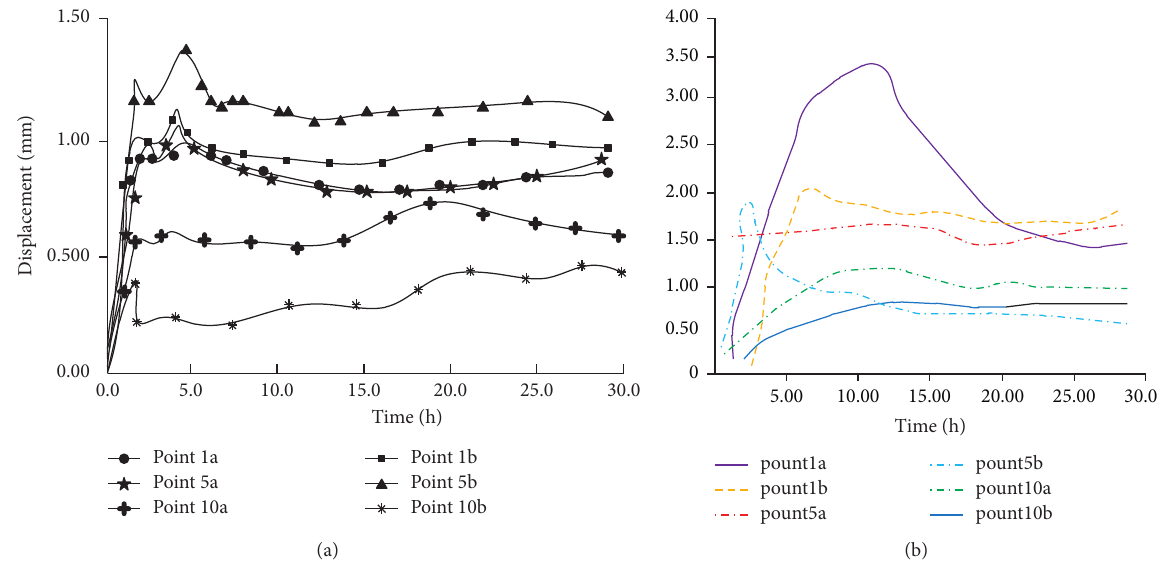
Figure 6: Curves of lateral displacement-time at 0.3m and 1.3m. (a) Bottom pressure change. (b) Change of lateral